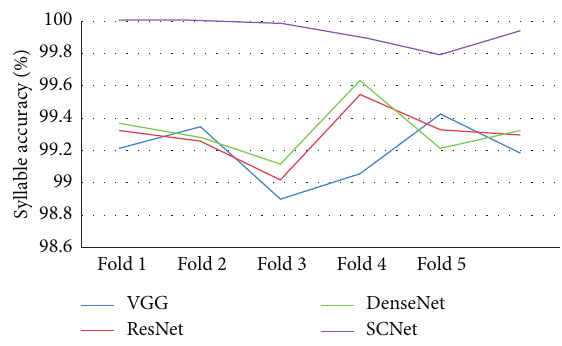
Figure 5: Vowel recognition results of different